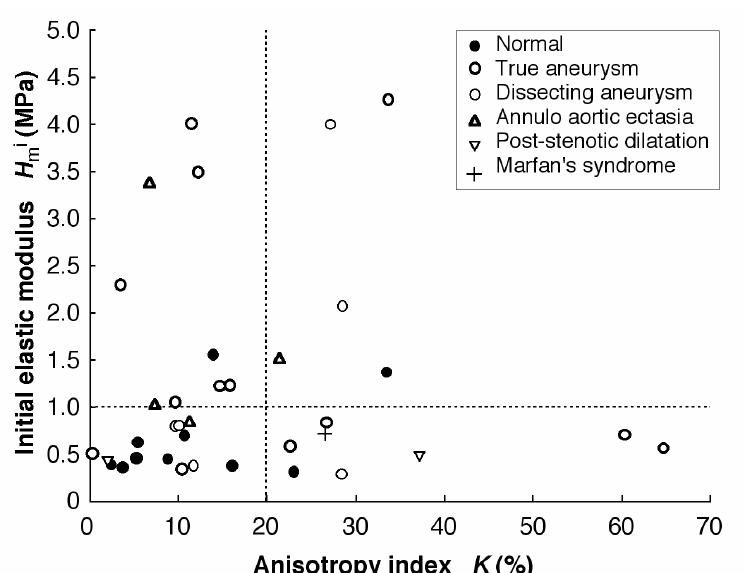
Fig. 5 Scattergram of mean initial elastic modulus and anisotropy index obtained from nonaneurysmal and various aneurysm